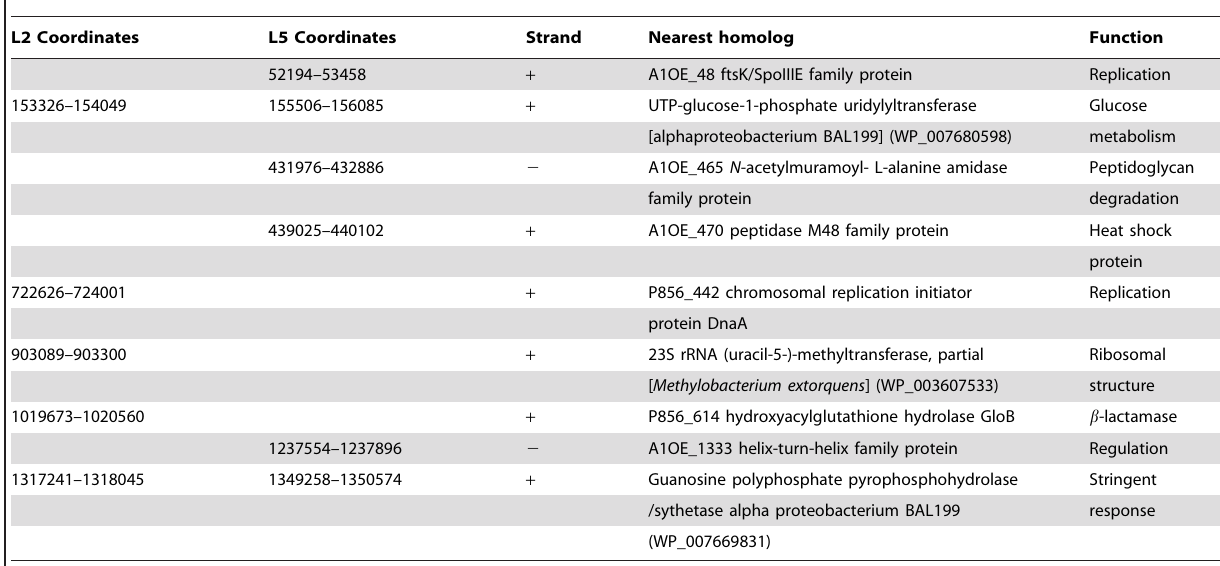
Table 2. Pseudogenes in Ca. E. faulkneri L2 and